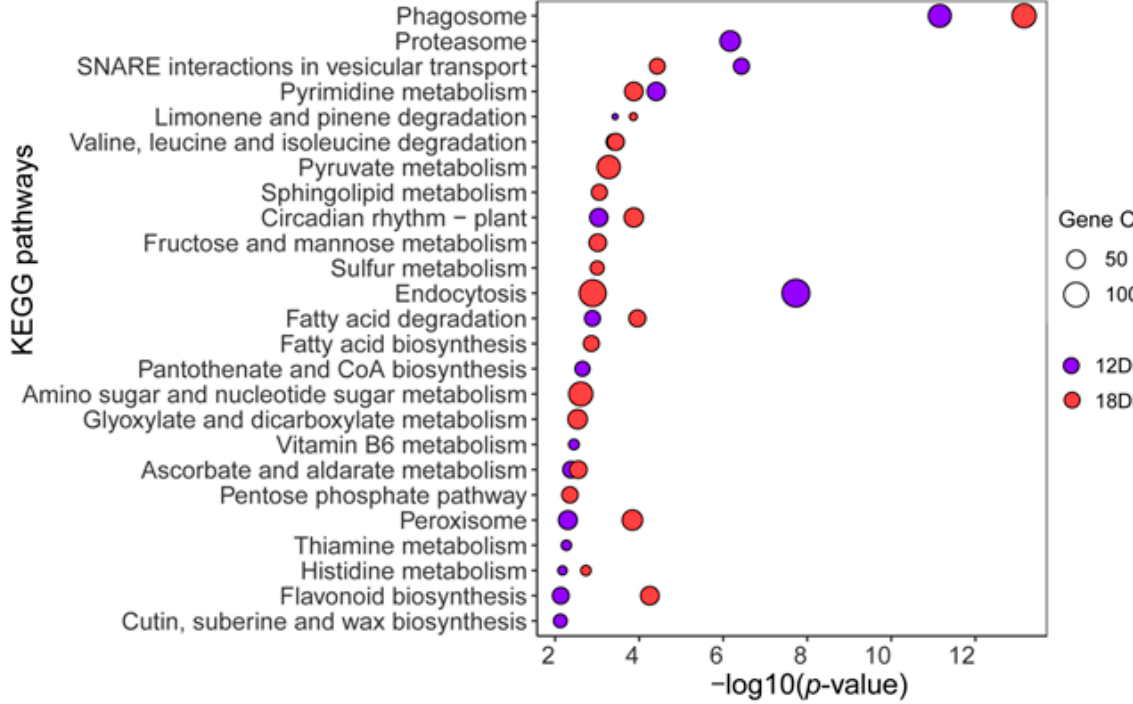
Figure 5. KEGG pathway enrichment analyses of the genes differentially expressed between Gossy- pium stocksii fibers of 6, 12 and 18 DPA.